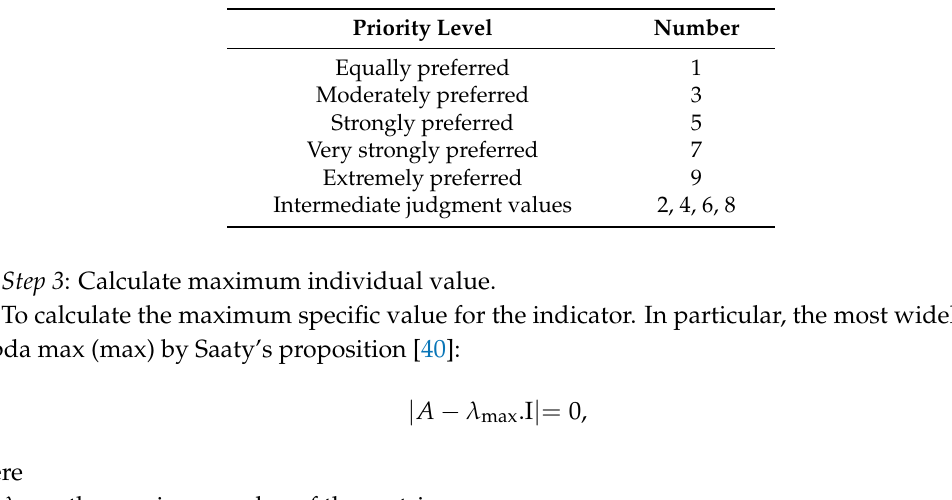
Table 2. Priority rating